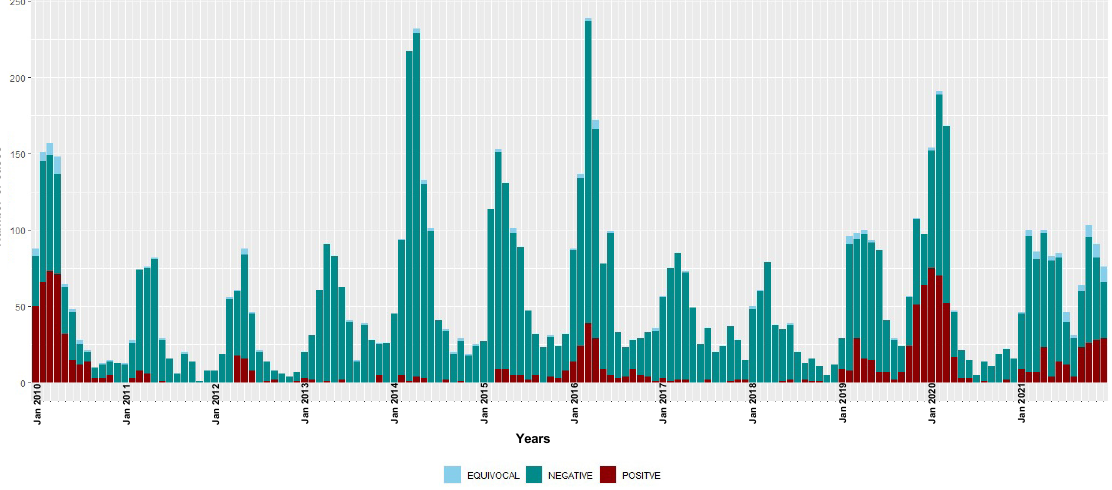
Figure 1. Temporal distribution of measles IgM-positive, equivocal and negative cases, 2010–2021. Bars are stacked and total bar height represents the number of suspected cases tested for measles IgM.